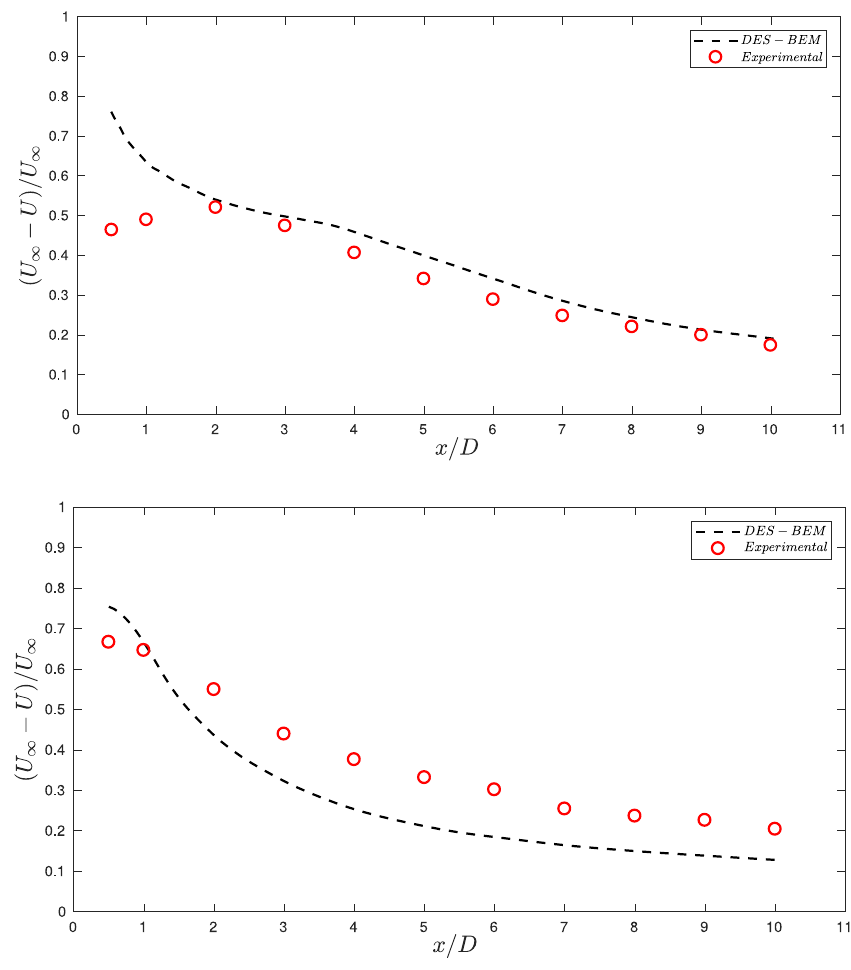
Figure 3. Longitudinal mean velocity (cid:104) U (cid:105) deficit for both study cases normalized by upstream velocity. The ST deficit ( top ) fits better to experiments than the TT case ( bottom ). At 10 D downstream, the wake recovered 80% of the mean streamwise